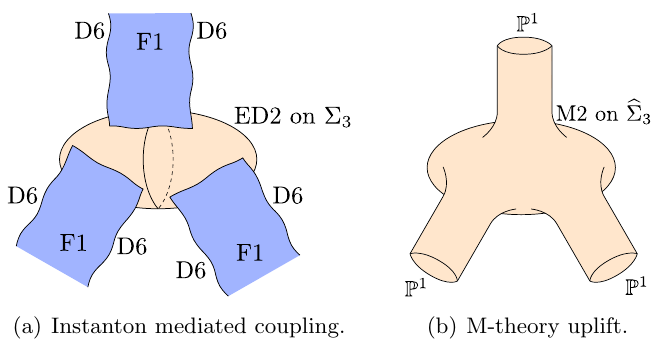
Figure 7 . (a) Schematic viewpoint of a instanton mediated coupling. Massless open strings between background D6 branes meet at the location of an euclidean D2 brane, which (assuming the right zero mode structure) can mediate an e(cid:11)ective coupling. (b) Its M-theory uplift, where the whole con(cid:12)guration has recombined into a non-compact three-cycle with three P 1